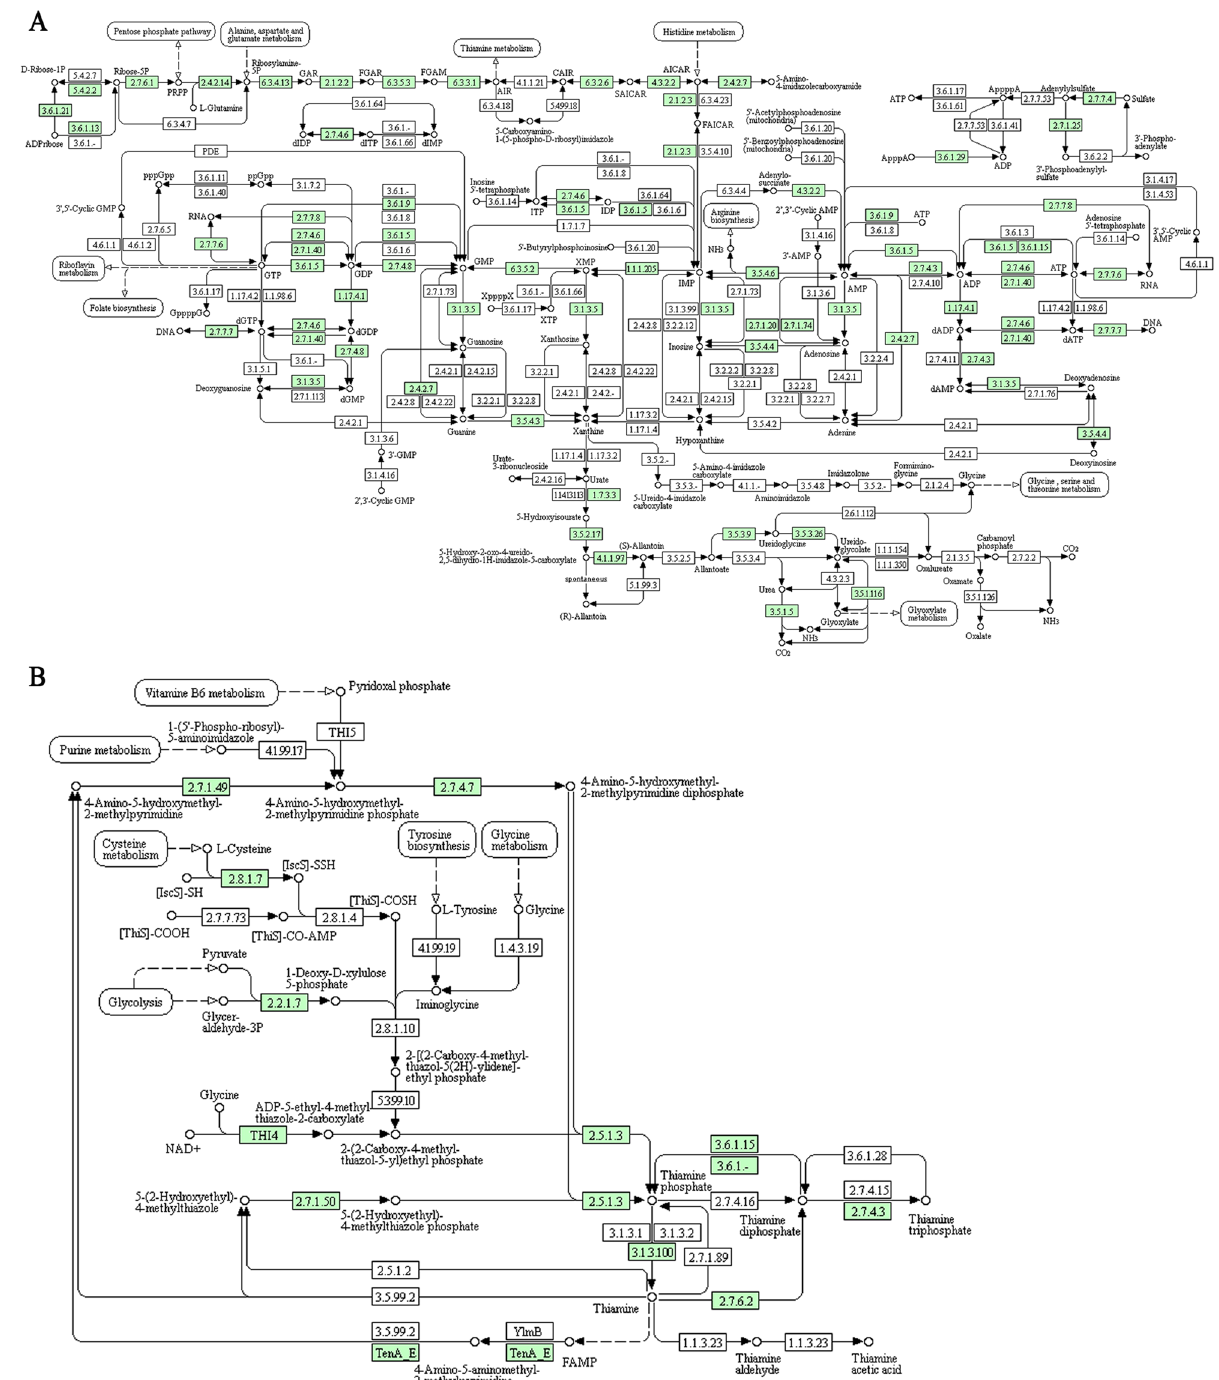
Figure 3. Analysis of purine ( A ) and thiamine ( B ) metabolism pathways by KEGG, showing the identified enzymes in Capparis spinosa leaf transcriptome (Enzyme Code - EC - identified are in